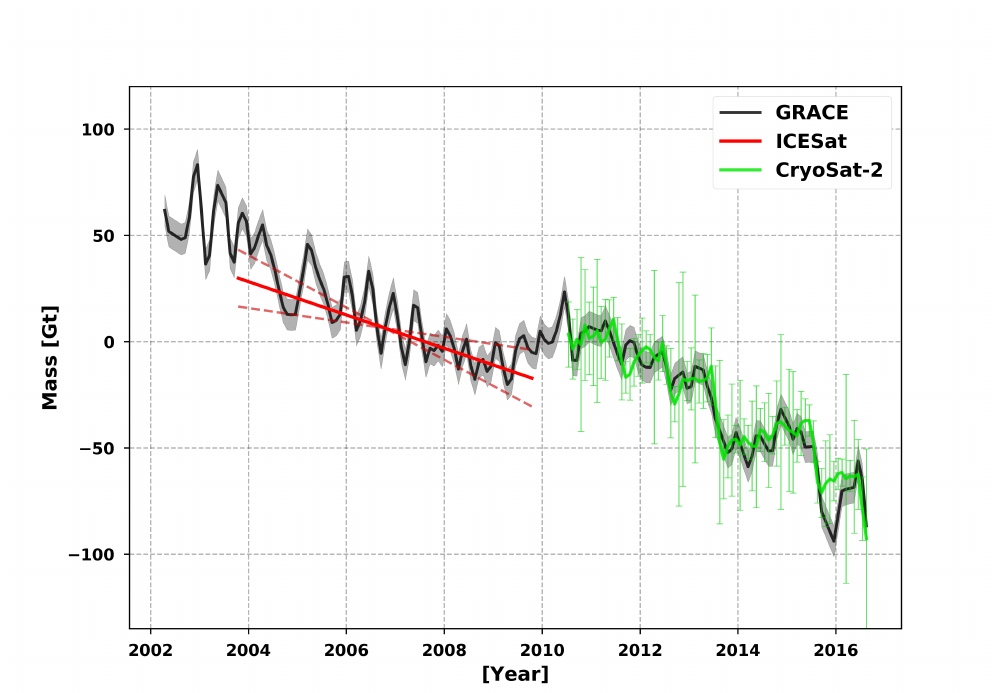
Figure 2. In black, NZEM glacier mass change time series derived from GRACE using a mascon inversion for the time period between April 2002 and August 2016 (monthly measurement error is grey shade). In red, regional glacier mass change using ICESat between October 2003 and October 2009 (range of variability in mass change is red dash). In green, regional mass change time series calculated using CryoSat-2 between July 2010 and July 2016 with vertical error